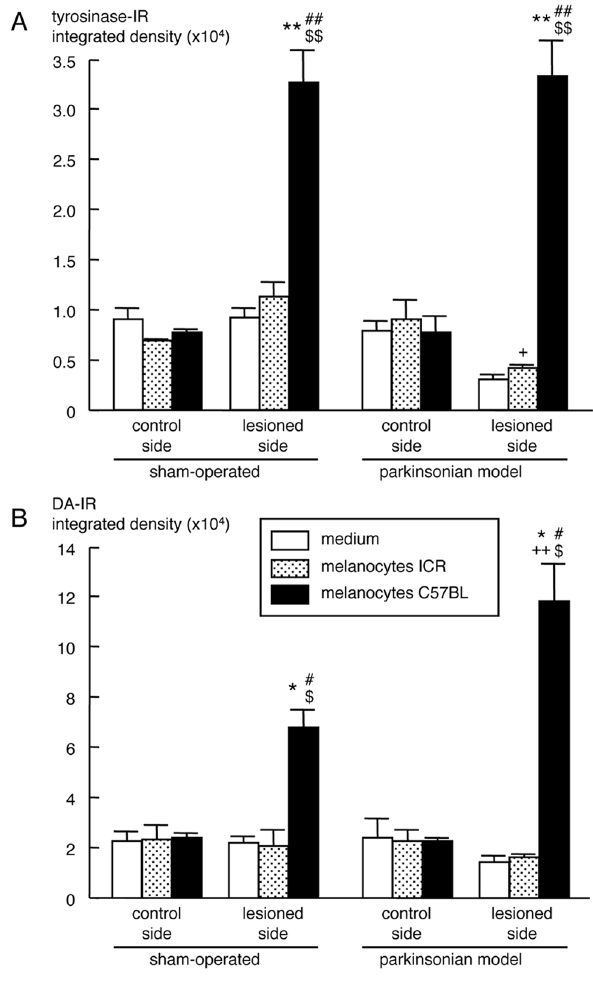
Figure 5. Tyrosinase-positive IR (A) and DA-IR (B) in the right lateral striatum around the transplant of hemi-parkinsonian albino mice and sham-operated controls at 88 days after intrastriatal transplantation of melanocytes obtained from albino (ICR) or black (C57BL) mice. Values are means integrated density of tyrosinase-IR or DA-IR 6 SEM (n = 3–4). * p , 0.005, ** p , 0.0001 vs. intact control side of each treated group. # p , 0.005, ## p , 0.0001 vs. side-matched medium-injected control group. $ p , 0.005, $$ p , 0.0001 vs. side-matched melanocytes from ICR mice- transplanted group. + p , 0.05, ++ p , 0.0005 vs. side- and treatment- matched sham-operated.